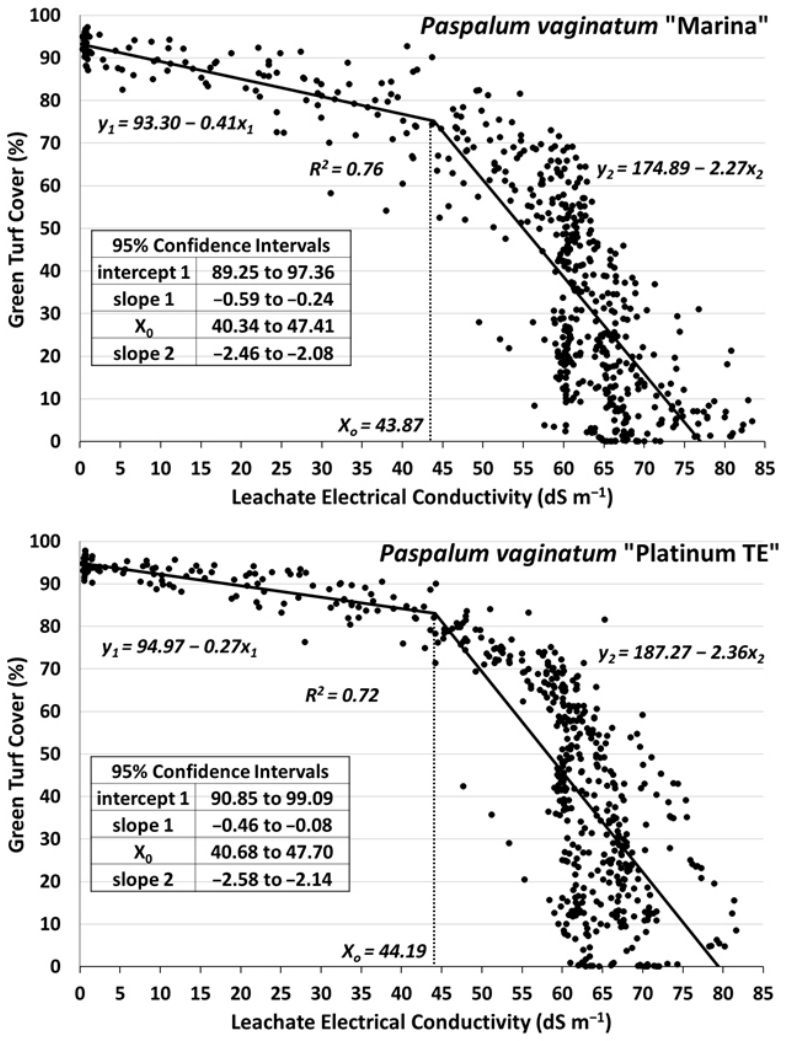
Figure 8. Two-segment linear regression models for the two Paspalum vaginatum varieties “Marina” and “Platinum TE” to determine green turf cover (%) reduction resulting from leachate electrical conductivity (dS m − 1 ) increase, when data from all treatments were pooled for the salinity stress period (29 July–13 September 2016).